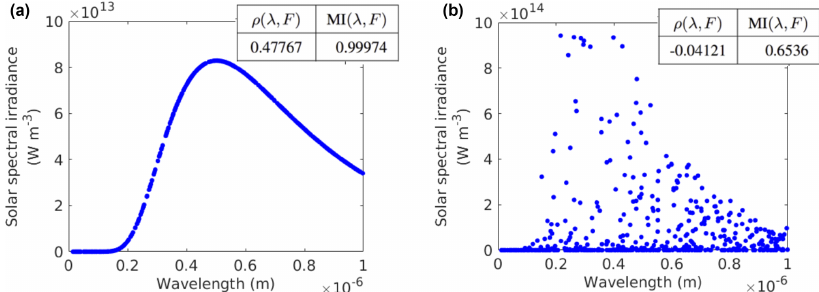
Figure 5. The relationship between solar spectral irradiance and wavelength. The notations ρ and MI represent the Pearson correlation coefficient and mutual information,